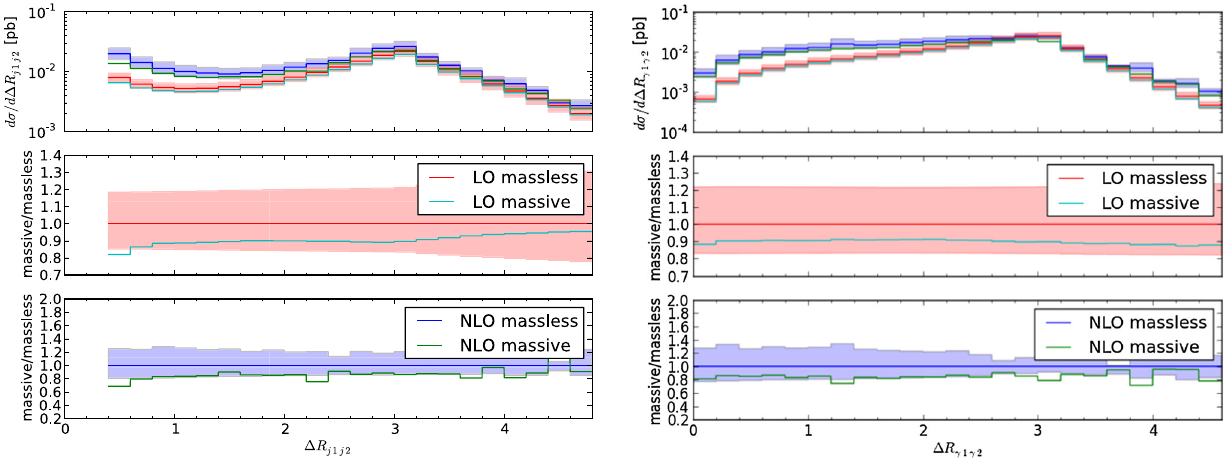
Fig. 11 Angular separation between the two leading jets (l.h.s.) and the two photons (r.h.s.) for massive b